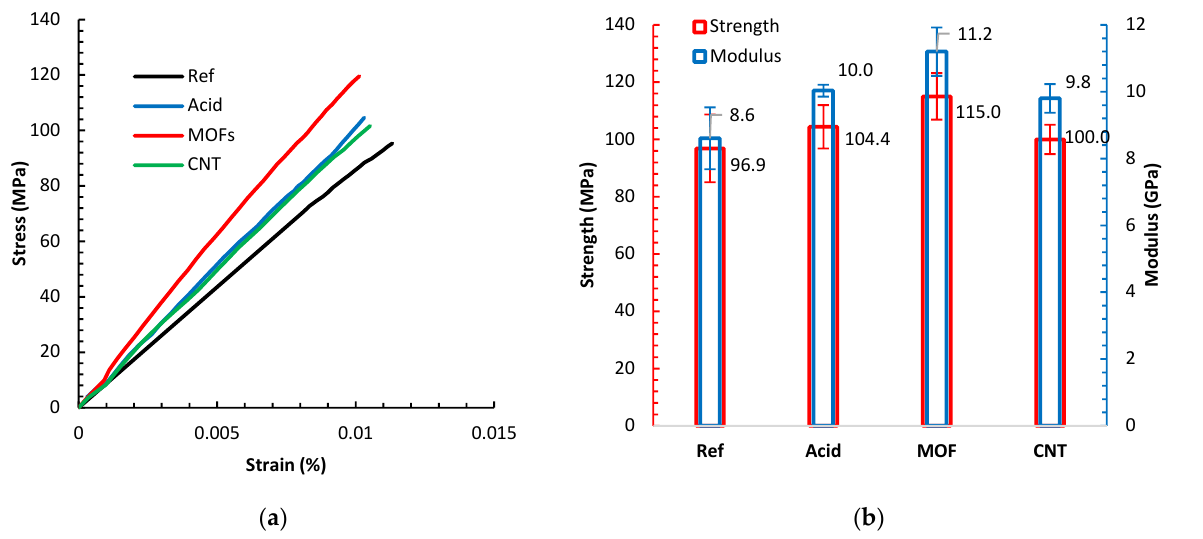
Figure 6. ( a ) Sample tensile tests for the composites with various fiber treatments. ( b ) The averaged stiffness and tensile strength of the different composites. Error bars denote the standard deviation .